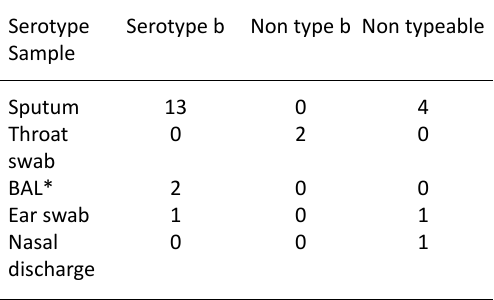
Table 2. Distribution of serotypes of H. influenzae by sample